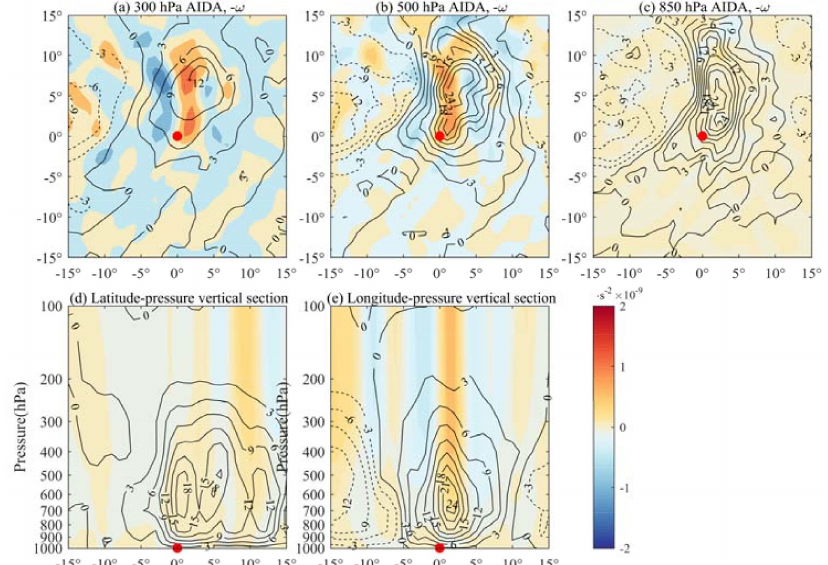
Figure 12. Composite horizontal distribution of the vertical velocities (contours, unit: − 1 hPa/s), and vertical motion induced vorticity change (the ADIA term, color shading, unit: 10 − 9 s − 2 ) in the cyclone region at the 300 hPa ( a ), 500 hPa ( b ) and 850 hPa ( c ), respectively, in the cyclone centered coordinate, and vertical sections of the vertical velocities (contours, unit: − 1 hPa/s) and vertical motion induced vorticity change (the ADIA term, color shading, unit: 10 − 9 s − 2 ) along the 0 ◦ latitude ( d ) and 0 ◦ longitude ( e ) in the cyclone centered coordinate, based on the selected cyclones in the Northwest Atlantic. The red spot is the center of the extratropical cyclone at the sea